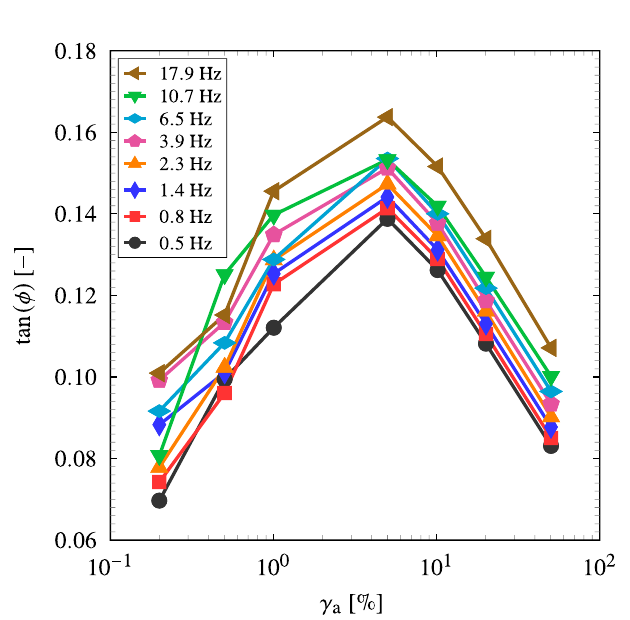
Table 2. The average critical tearing energy energy for different unloading rates